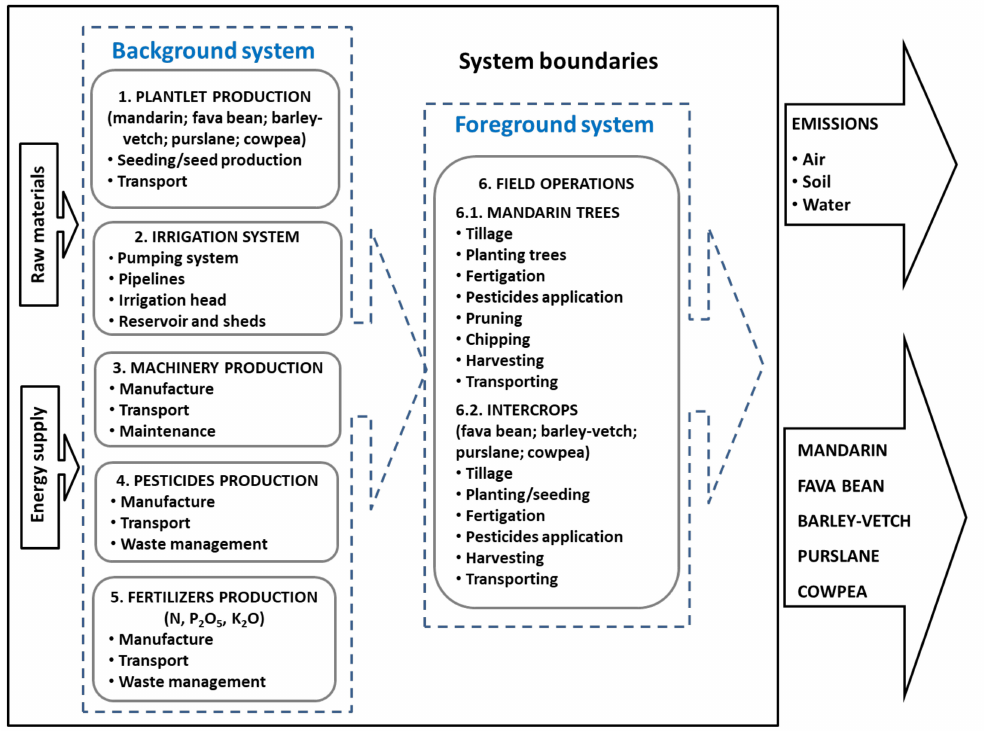
Figure 2. System boundaries for ‘cradle-to-gate’ production of mandarin and